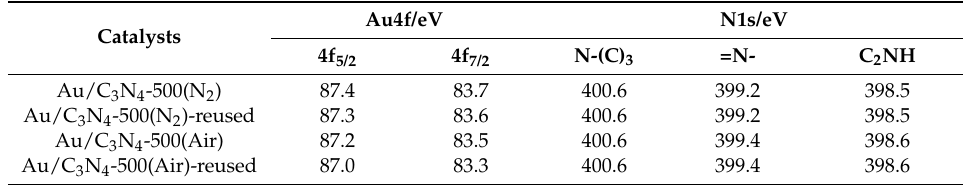
Figure 3. XPS core level spectra of ( a ) Au4f in Au/C 3 N 4 -500(N 2 ); ( b ) N1s in Au/C 3 N 4 -500(N 2 ) and ( c ) Au4f in Au/C 3 N 4 -500(Air); ( d ) N1s in Au/C 3 N 4 -500(Air). Table 1. XPS binding energy of Au4f and N1s in the Au-supported C 3 N 4